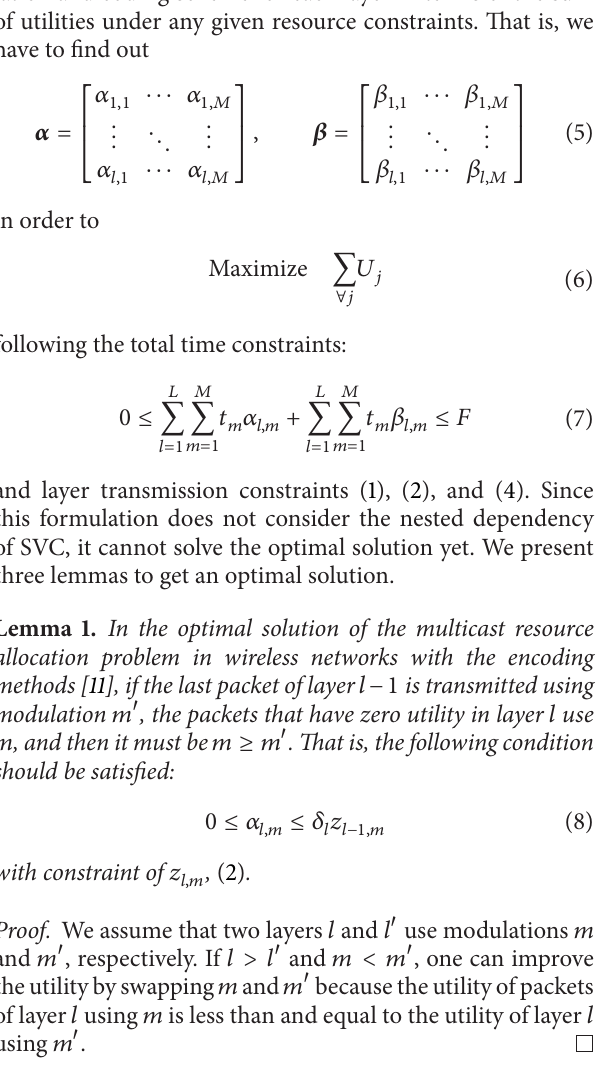
Figure 3: The difference between the original PSNR and approxi- mated PSNR in a couple of packet